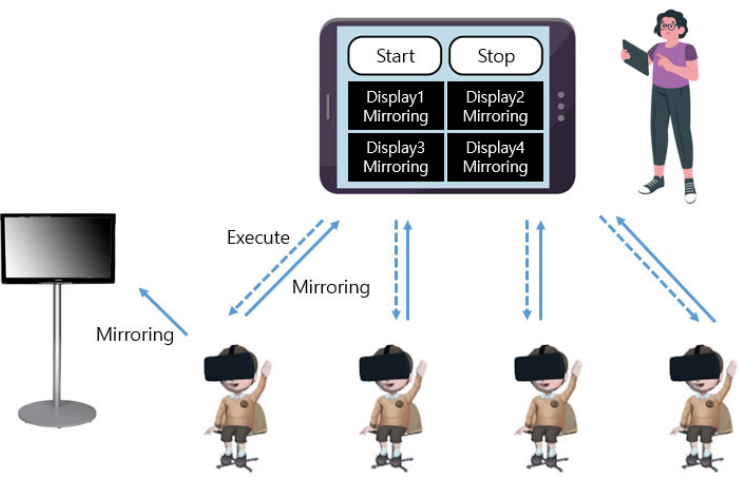
Figure 2. Schematic of Infant VR life safety education procedure.